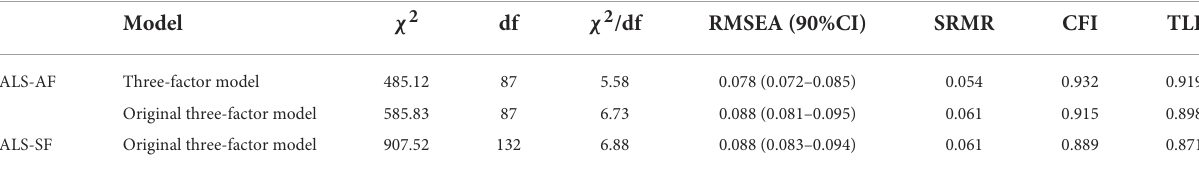
TABLE 3 Fit indices for the competing factor models ( n = 744).